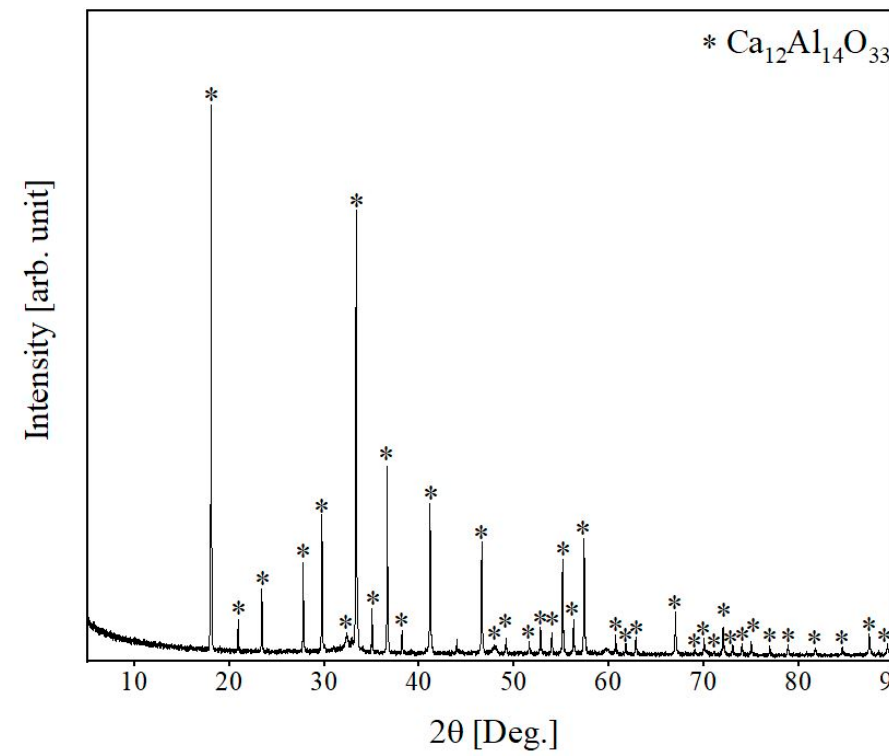
Figure 4. XRD pattern of R slag.